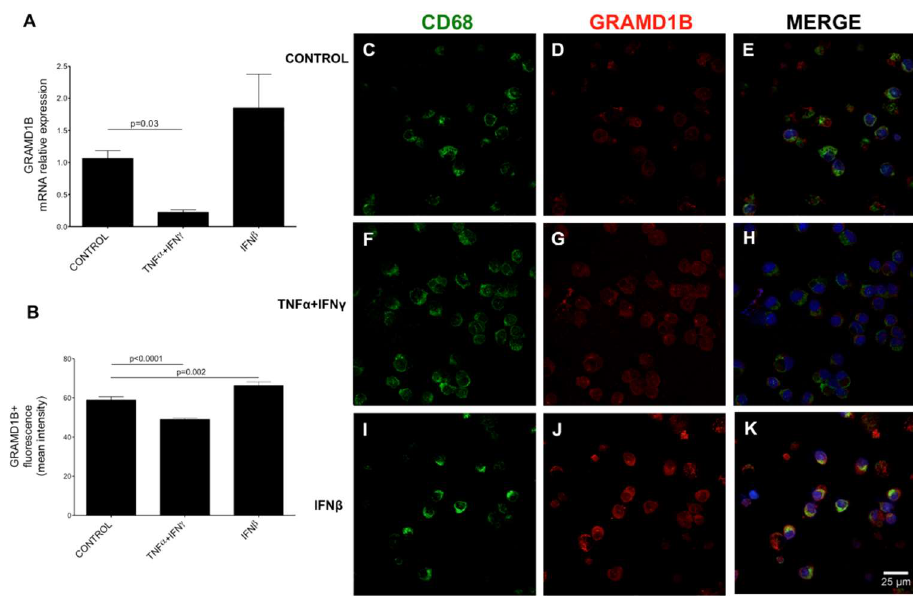
Figure 8. GRAMD1B expression in macrophages/monocytes of control subjects before and after stimulation with inflammatory cytokines. Peripheral blood macrophages/monocytes from four HC blood samples were cultured and stimulated with different inflammatory cytokines. GRAMD1B expression was measured at mRNA level by quantitative RT-PCR ( A ) and at protein level by immunocytochemistry ( B – K ). ( A ) Quantitative RT-PCR quantification of GRAMD1B mRNA expression in basal conditions, after TNFα- and IFNγ stimulation and after IFNβ stimulation. ( B ) Quantification of the GRAMD1B signal in different fields at resting conditions (control), after TNFα- and IFNγ stimulation and after IFNβ stimulation. ( C – E ) Unstimulated cells. ( F – H ) TNFα- and IFNγ- stimulated cells. ( I – K ) IFNβ-stimulated cells. The panels on the right show the merged staining for GRAMD1B (in red) and the CD68 monocyte marker (in green).